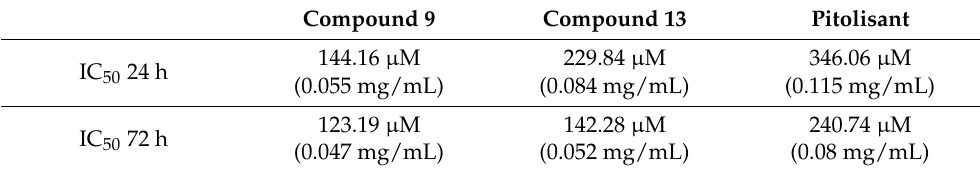
Table 7. IC 50 values obtained for compounds 9 and 13 against human astrocyte cell lines assessed by MTT